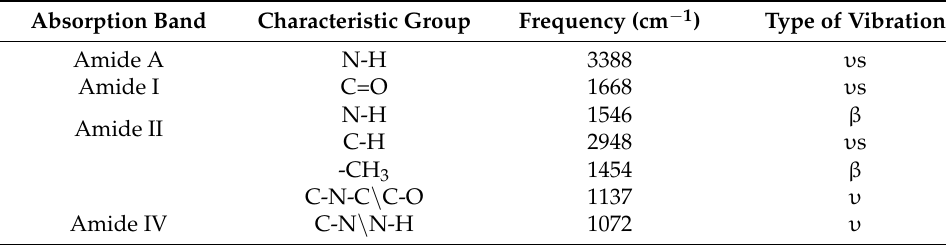
Table 2. Characteristic absorption peaks in the infrared spectrum of HAAM.